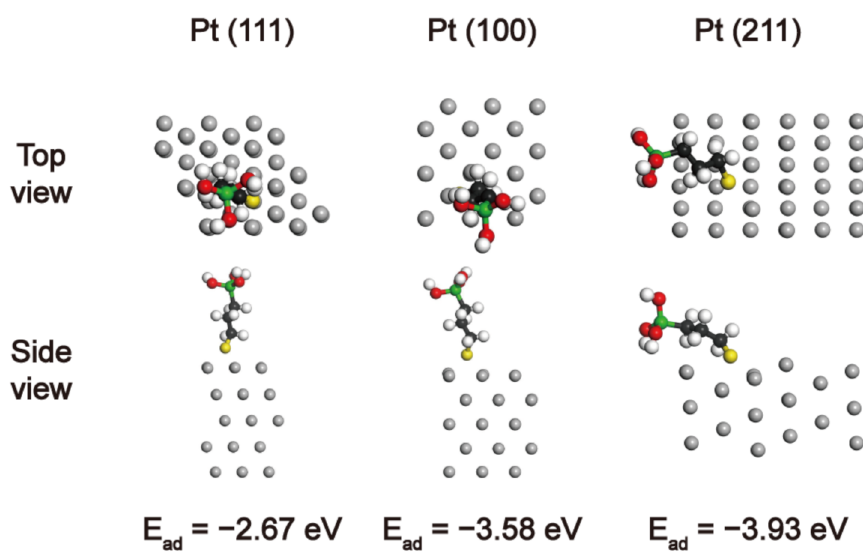
Figure 2. Theoretical computations of the adsorption energy of MPTES on Pt (111), (100), and (211)